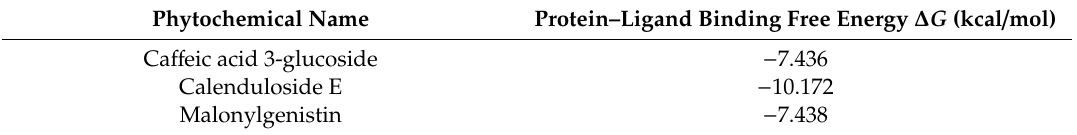
Table 2. Calculated binding energies between DPP-4 and phytochemicals of garlic bulb extract.